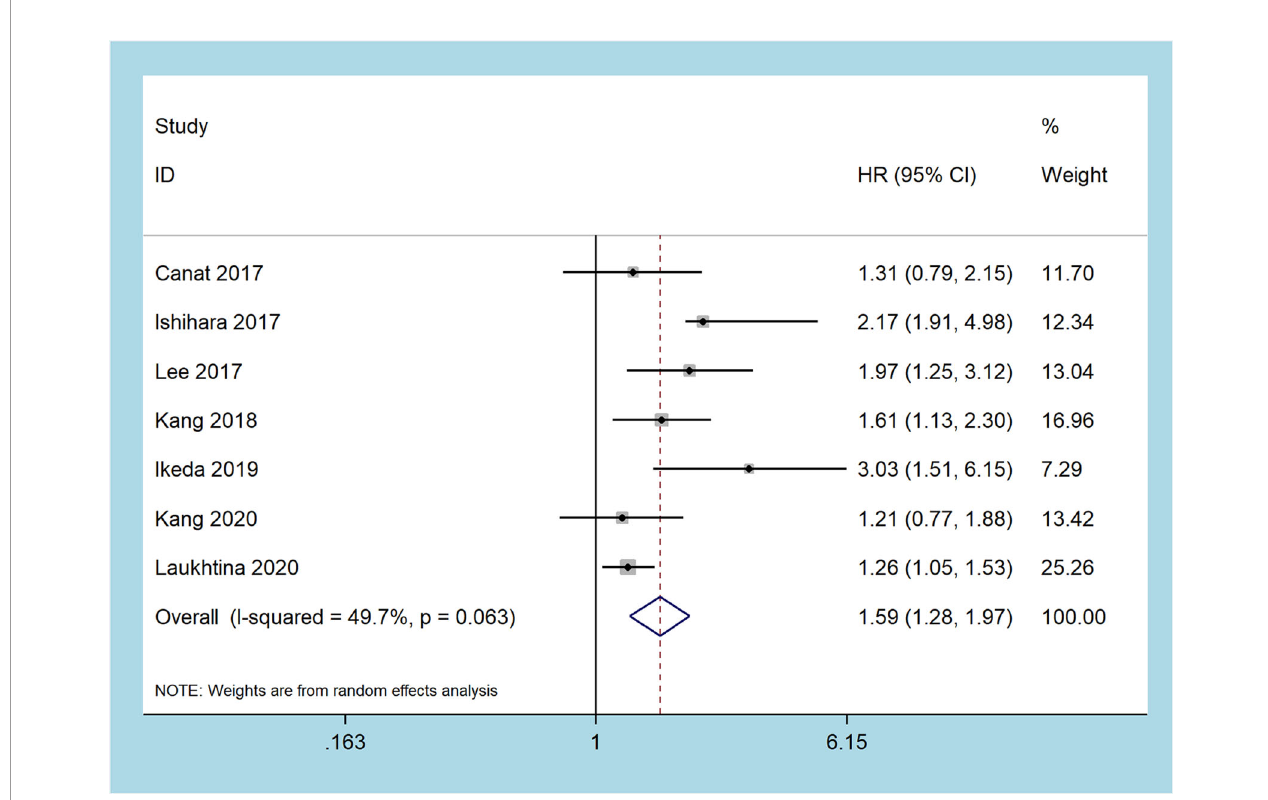
FIGURE 3 | Forest plots of the association between the De Ritis ratio and cancer-speci fi c survival.